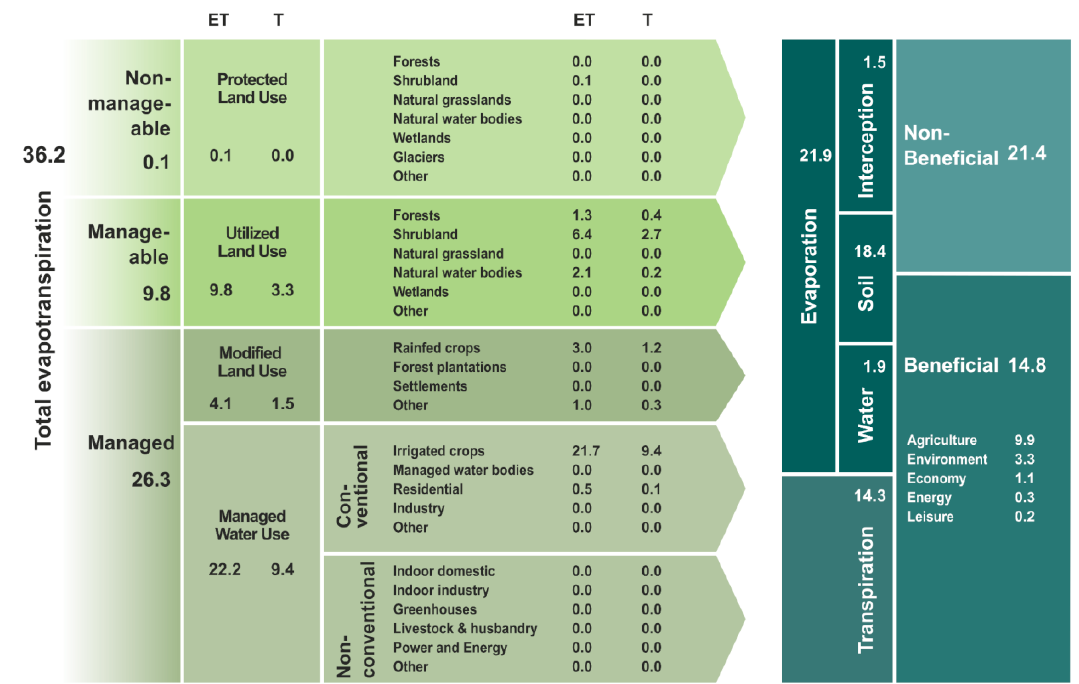
Figure 12. Sheet 2 was generated using WA+ with details of total water consumption in the basin for PERSIANN precipitation datasets based on dry year (2014-15).